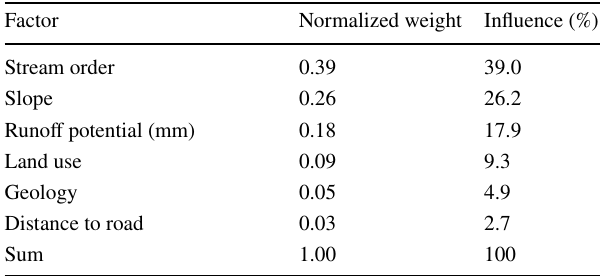
Table 9 The Eigenvector weights of each flood factor obtained after the pairwise comparison